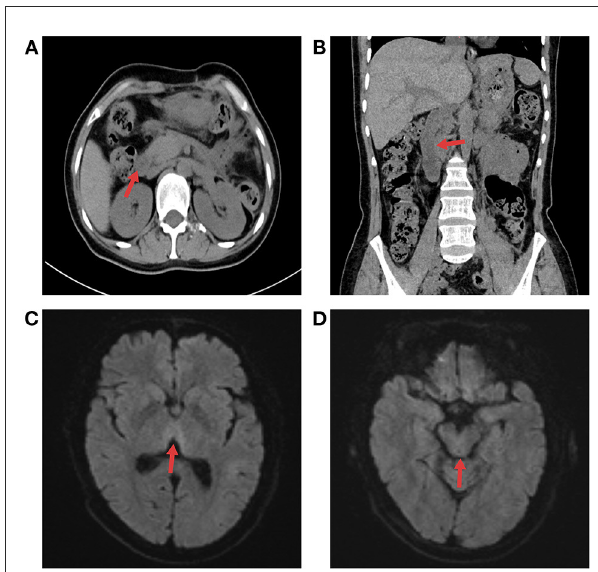
FIGURE3 The follow-up radiographic results. (A, B) Abdominal CT showed that pancreatic edema subsided, peripancreatic exudate was obviously absorbed, and the duodenum was not dilated or obstructed. (C, D) Cerebral MRI results at 3 months after discharge indicated that edema had disappeared in the medial thalamus and dorsal brain